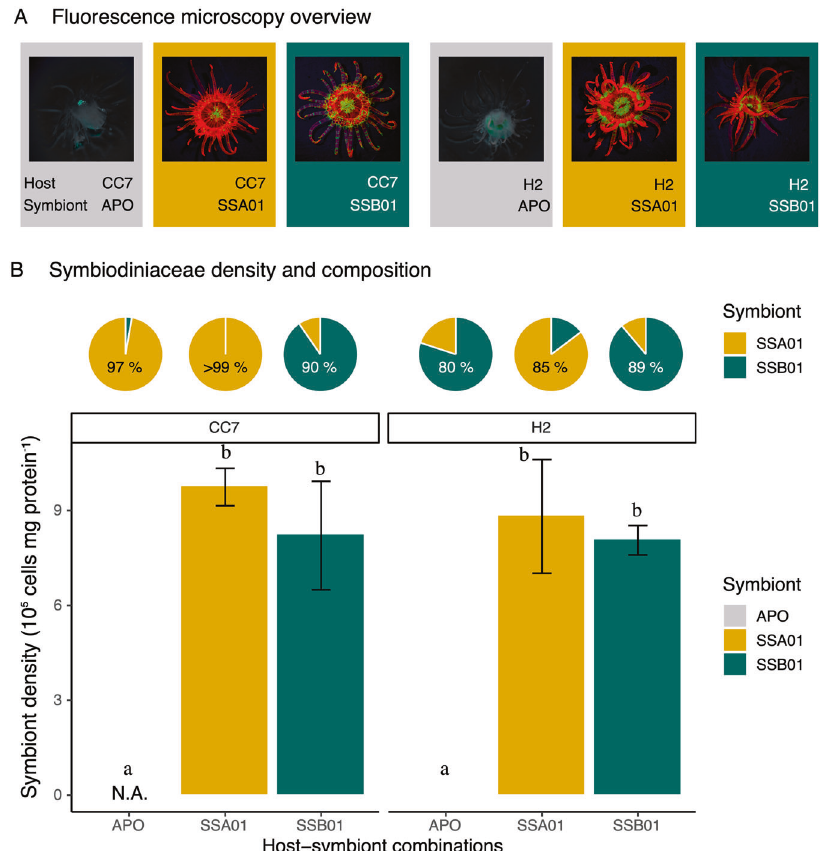
Fig. 1 Inoculations of aposymbiotic Aiptasia with algal symbionts. A Fluorescence microscopy overview of six host-symbiont combinations to visualize in hospite chlorophyll of photosymbiotic Symbiodiniaceae. B Symbiodiniaceae density and community composition of six host- symbiont combinations. All data are shown as mean ± SE ( n = 5 animals each). Different letters above bars indicate signi fi cant differences between groups (two-way ANOVA with Tukey HSD, P < strains (Fig. 3; Kruskal – Wallis, P = 0.438), but signi fi cantly differed across photosymbiotic associations (Fig. 3; Kruskal – Wallis, signi fi cant difference between host strains (Supplementary Fig. S2; P = 0.006). The relative abundance of denitri fi ers in Aiptasia with symbiont SSA01 were nearly 4- to 23-fold higher compared to their SSB01 photosymbiotic (Fig. 3; Kruskal – Wallis, P = 0.135) and aposymbiotic counterparts (Fig. 3; Kruskal – Wallis, P = 0.004).